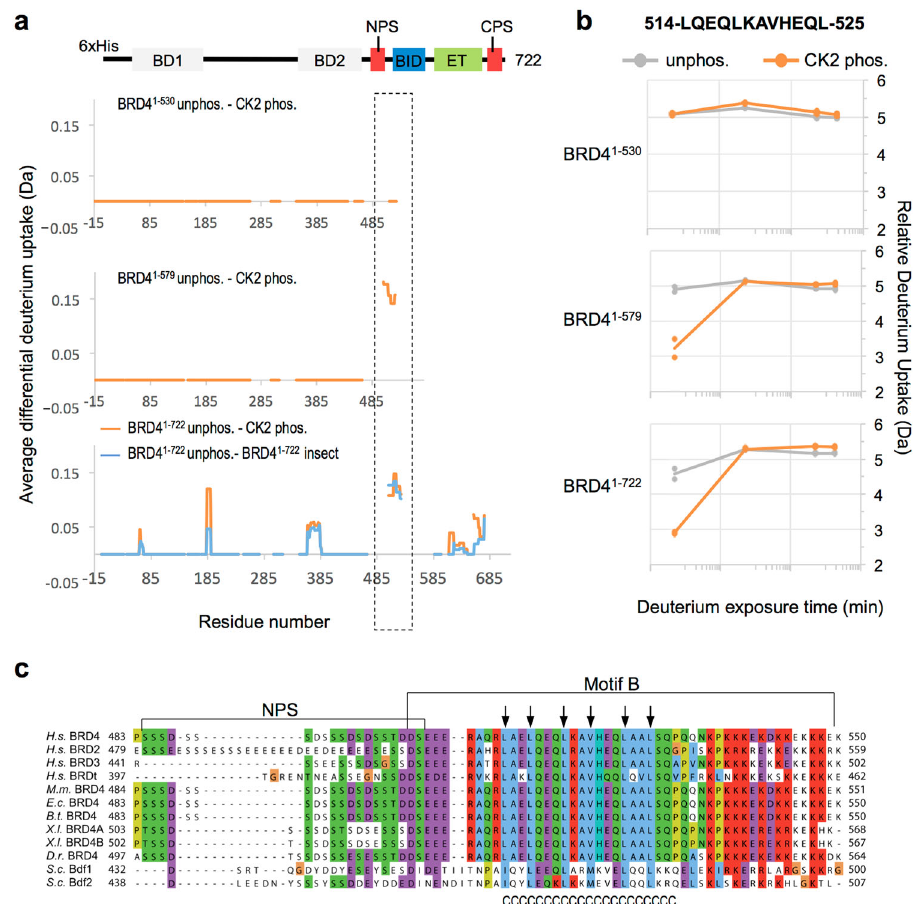
Fig. 2 Change in Hydrogen-Deuterium exchange of motif B upon BRD4 dimerization. a Average difference of deuterium uptake for each residue of the indicated constructs (BRD4 1 – 530 , BRD4 1 – 579 , and BRD 1 – 722 ) between the unphosphorylated sample (unphos.) and the sample subjected to CK2 phosphorylation (CK2 phos.) or puri fi ed from insect cell (insect). A positive differential uptake indicates a higher deuterium uptake (more exposed region) in the unphosphorylated sample and a protected region in the phosphorylated sample. Only peptides with changes above 0.5 Da and greater than 2.3x SD were taken into account. Areas with no coverage are represented as gaps. The protection upon phosphorylation of motif B observed in BRD4 1 – 579 and BRD4 1 – 722 , but not in BRD4 1 – 530 , is highlighted with a rectangle. In these graphs, regions showing EX1 kinetics are considered with no difference. For details on the calculation, see the Materials and Methods section. Orange lines indicate the difference in deuterium update between unphosphorylated BRD4 1-722 and BRD4 1-722 phosphorylated by CK2 in vitro. Blue lines indicate the difference in deuterium update between unphosphorylated BRD4 1 – 722 and insect cell-expressed BRD4 1 – 722 , b Example of a peptide in the region spanning aa 506-527 showing notable deuterium uptake differences over the shortest exposure time (3 sec on ice) upon CK2 phosphorylation in BRD4 1 – 579 and BRD4 1 – 722 , but not in BRD4 1 – 530 . The relative deuterium uptake (Da) over deuterium exposure time is reported for each n = 3 independent experiments. Orange lines indicate CK2 phosphorylated samples and grey lines indicate unphosphorylated samples. c Sequence alignment of human BET proteins and BRD4 proteins from various species performed with ClustalOmega and represented with ClustalW color scheme. H.s .: Homo sapiens ; M.m .: Mus musculus ; E.c.: Equus Caballus ; B.t.: Bos taurus ; X.l.: Xenopus laevis ; D.r .: Danio rerio ; S.c .: Saccharomyces cerevisiae . The conserved NPS region with consensus CK2 phosphorylation sites (S/TxxE/D, where x is any residue) and Motif B are indicated. The JPred secondary structure prediction is reported below the sequences where residues predicted to be in a coiled coil are indicated below by ‘ C ’ . Arrows point towards the conserved hydrophobic residues within the coiled-coil region that are predicted to form the inner hydrophobic interaction